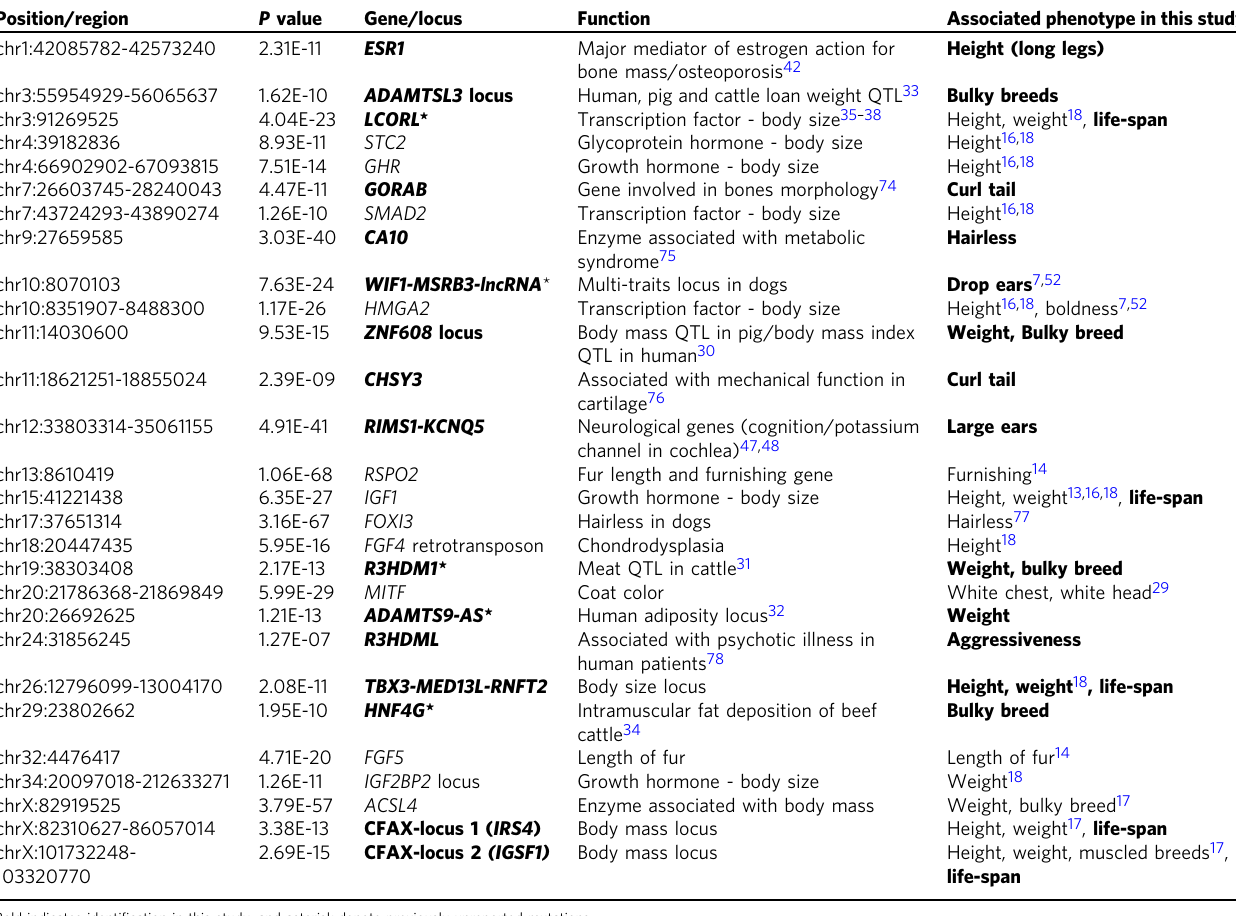
Table 2 Summary of signi fi cant associations identi fi ed by multiple GWAS using a maximum of 268 modern breed genomes Position/region P value